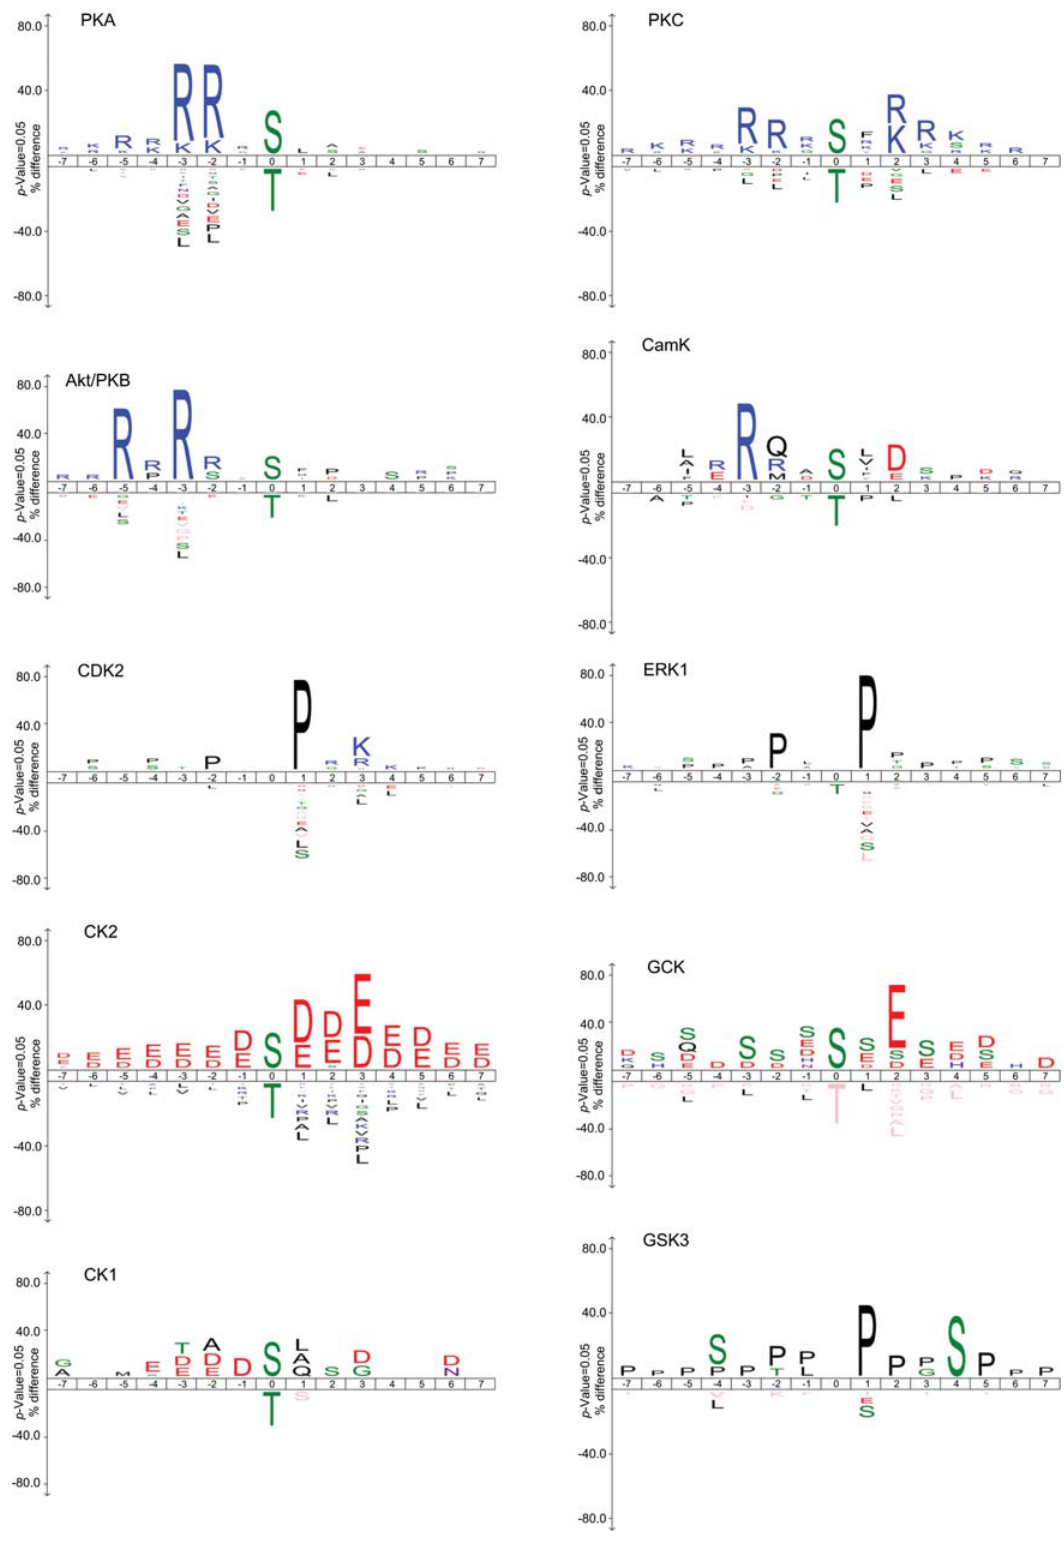
Figure 4 IceLogo analysis of phosphosites generated by individual protein kinases vs. random S/T proteome. Bona fide substrates for each kinase considered here have been extracted from PhosphoSitePlus (cid:2) and PhosphoElm (15); CK2 substrates have been collected from Ref.